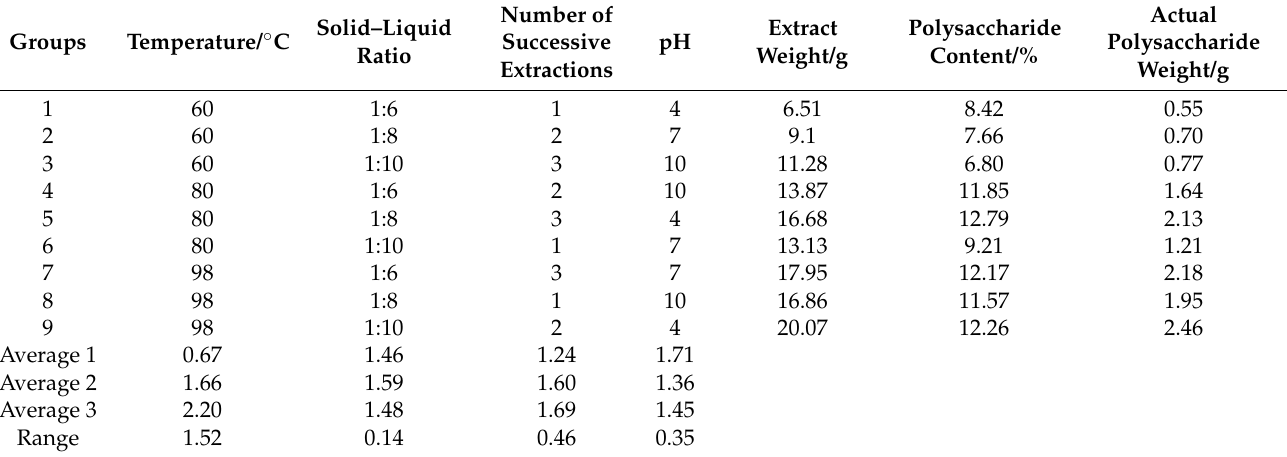
Table 1. Orthogonal experiments under different extraction conditions.